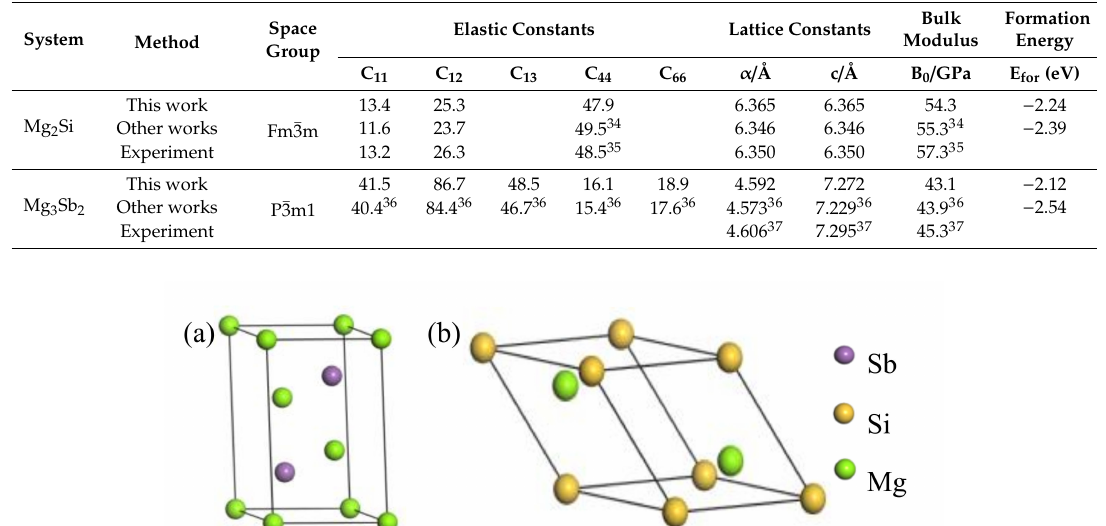
Table 1. Calculated and experimental value of the lattice constants, bulk modulus and formation energy of Mg 2 Si and Mg 3 Sb 2 .